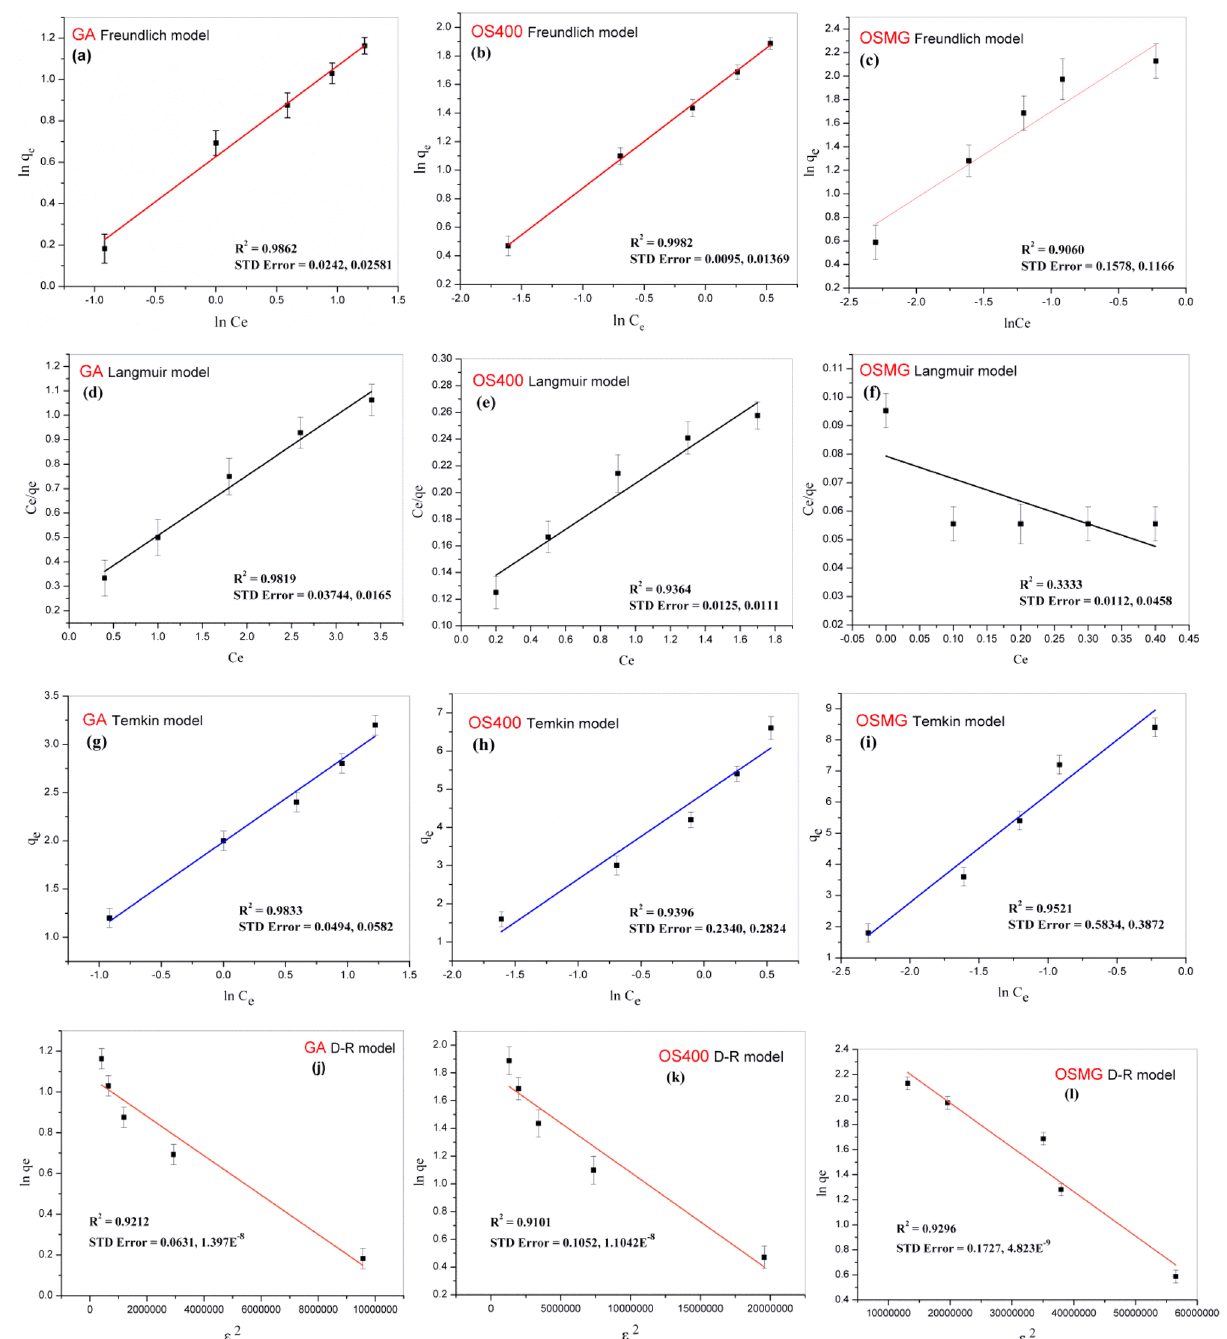
Figure 10. The linear plots of ( a , b and c ) Freundlich, (d, e and f) Langmuir, ( g , h and i ) Temkin, ( j , k and L ) D-R isotherm models for GA, OS400 and OSMG adsorbents,